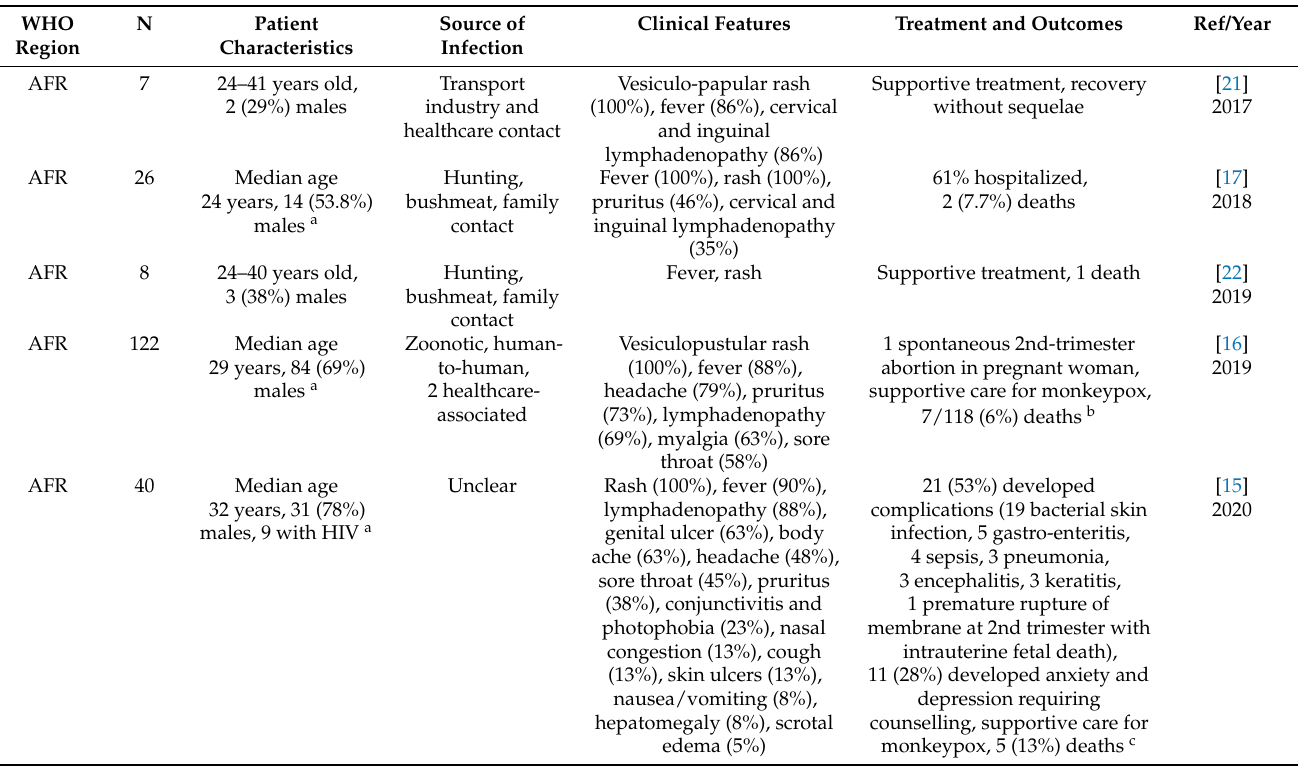
Table 2. Adult cases of monkeypox virus infection in